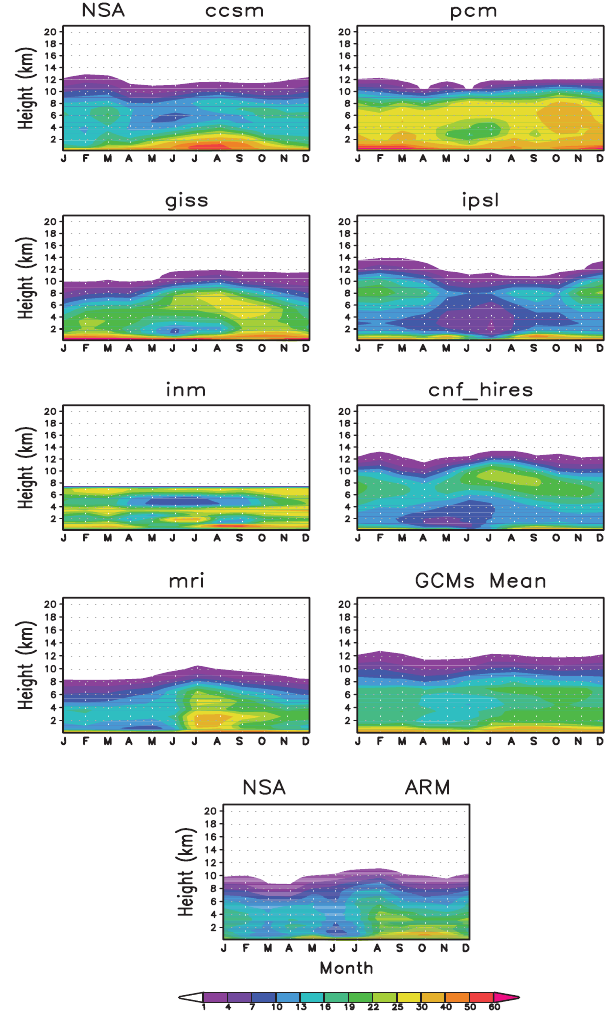
Fig. 14. Same as for Fig. 10, but for